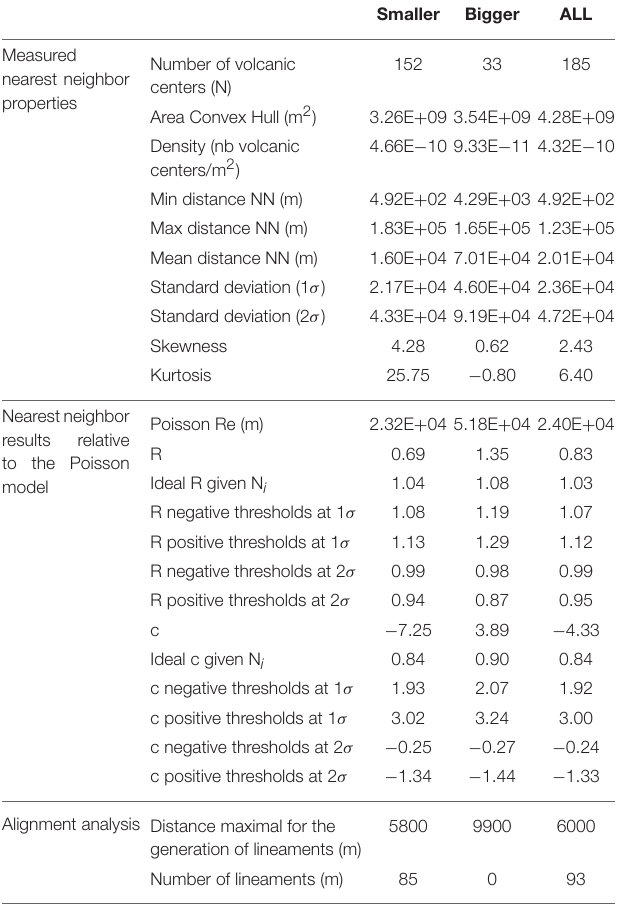
TABLE 2 | Properties and results of the statistical analyses for each morphological subgroup (big and small), and for the all the volcanoes in the Hat Creek